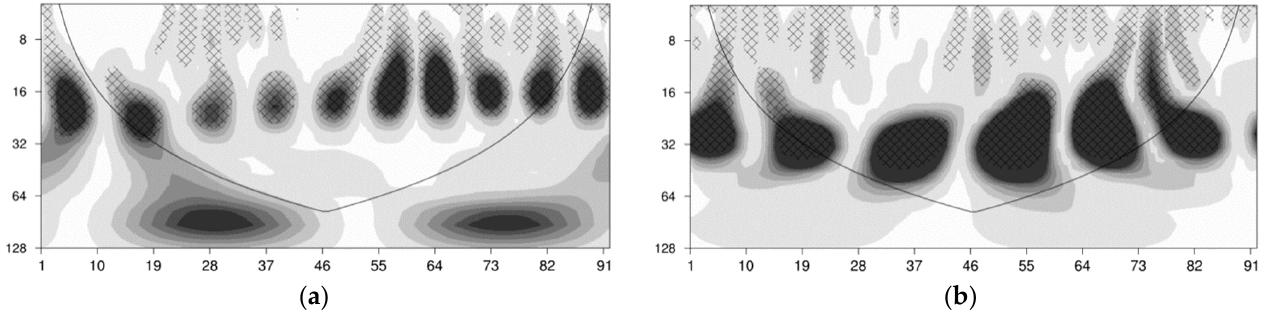
Figure 3. Wavelet spectra of EASM index sequences (the abscissa is June-August and the ordinate is period (day), grid area passes 95% significance test). ( a ): 2010; ( b ): 1997. Table 1. Typical years of two types of ISO of EASM in 1979–2019. Cycle Typical